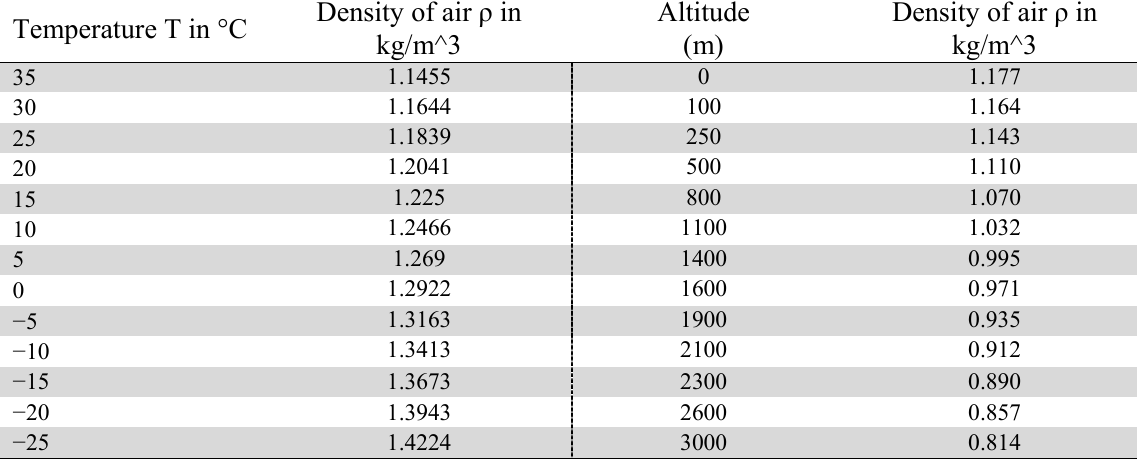
Density of air sensitivity against Temperature and